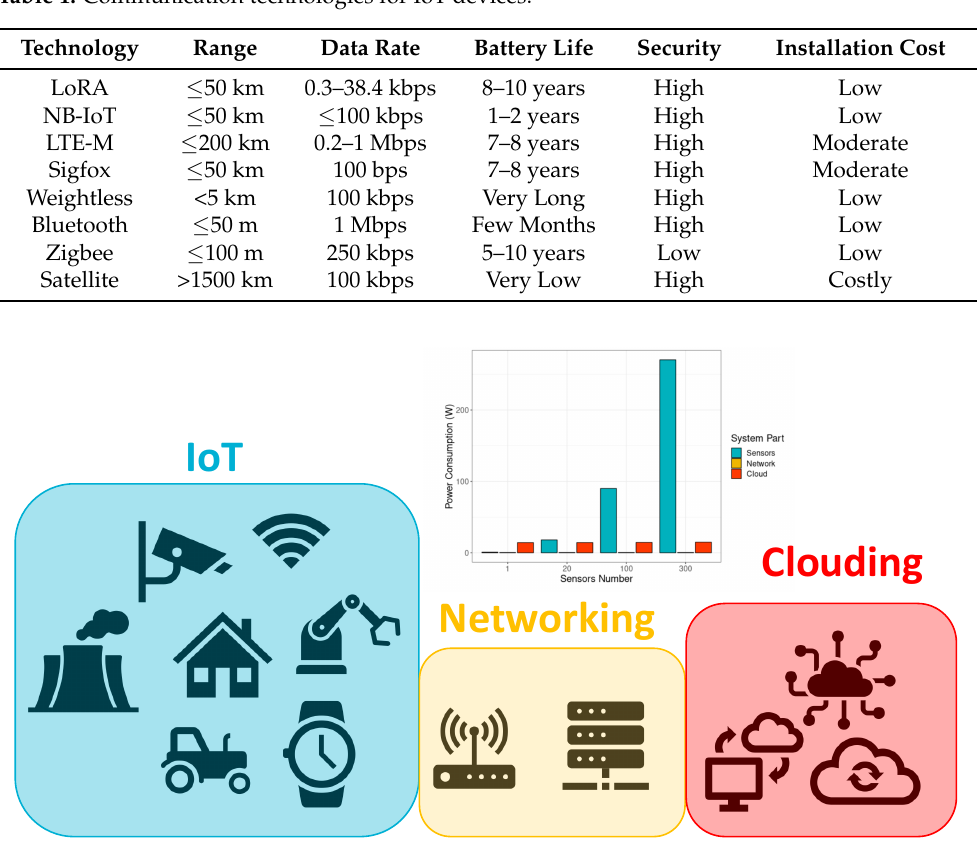
Figure 3. Power consumption of IoT